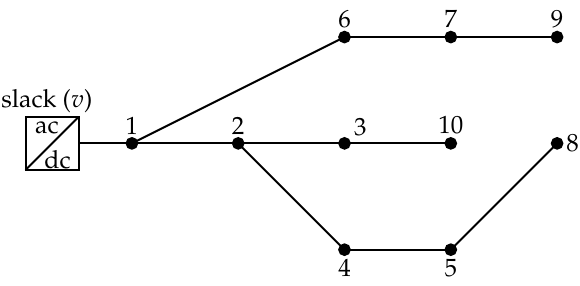
Figure 4. Electrical configuration for the 10-test test feeder after of the optimal reconfiguration plan.